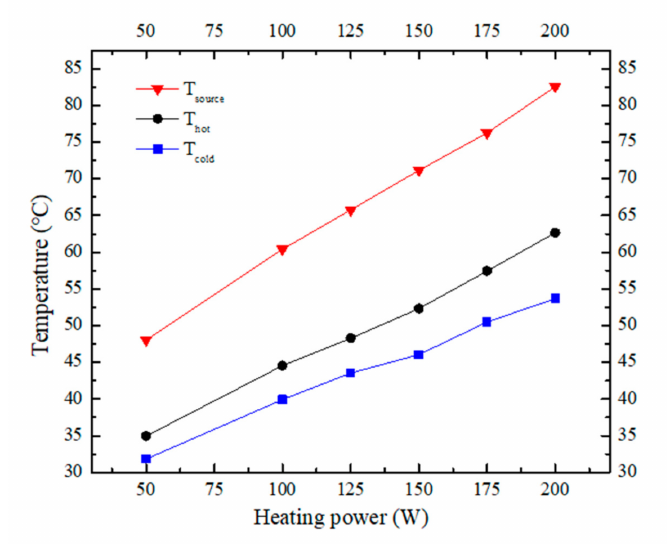
Figure 16. Temperature variation under di ff erent heating